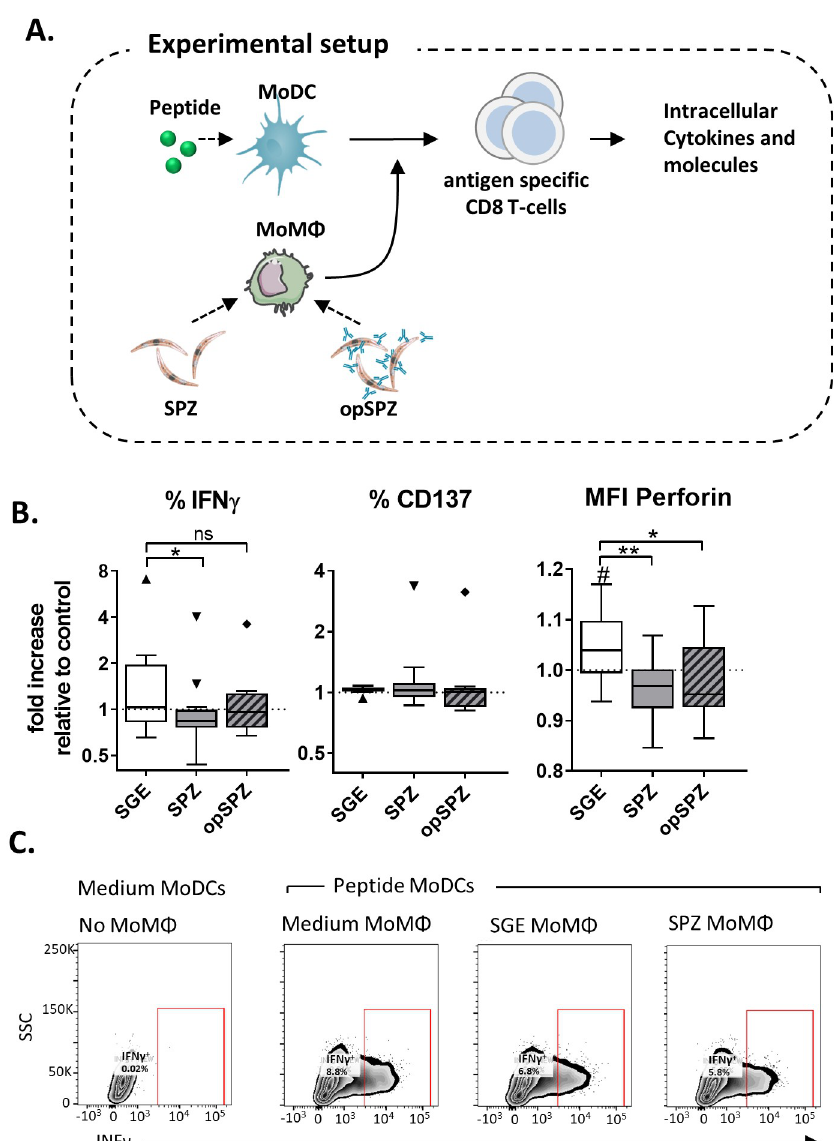
Fig 6. Immune suppression by Pf SPZ stimulated macrophages. A . Experimental setup. Peptide stimulated MoDCs are co-cultured with a peptide specific CD8 + T cell clone in the presence or absence of parasite or control stimulated MoM ϕ s (information in materials and methods). B . CD8 + cell phenotype after overnight co-culture with MoDCs and MoM ϕ s. Intracellular IFN γ , activation marker CD137 and Perforin expression. Analysis using Wilcoxon test, N = 4, 8 donors. #: P = < 0.05 compared to medium control. � : P = < 0.05, �� : P = < 0.005. C . Representative cytometry plots showing percentage of IFN γ + CD8 + T cells.